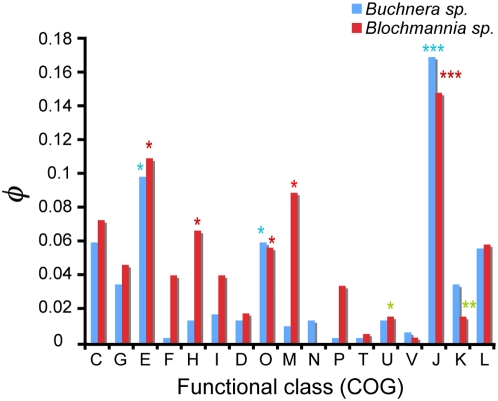
Distribution of genes under functional divergence among the functional categories in Buchnera sp. (blue bars) and Blochmannia sp. (red bars).The different functional categories as explained by the Cluster of Orthologous Groups (COG) are represented in the X-axis. The height of the bar represents the relative contribution of each class (i) of size (t), to the total number of genes under functional divergence (ni: R(ω) = ωe/ωf<1) when considering the whole dataset (T). This normalized number hence was calculated as φ = (ni/t) * (t/T). Classes showing significant enrichment with genes under functional divergence under a hypergeometric distribution are labeled by (*, P<0.05; **, P<10−2; ***, P<10−3). We also labeled those functional classes significantly underrepresented by highly constrained genes using green stars.